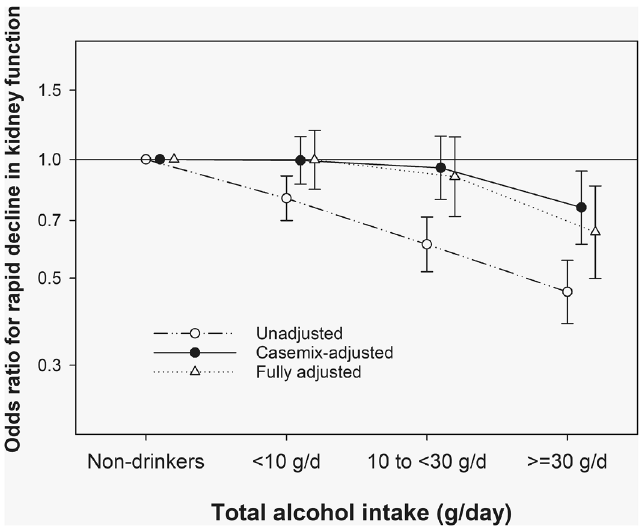
Figure 4. Association between total alcohol intake and rapid decline in kidney function (odds ratios) with three levels of adjustment in relation to baseline alcohol consumption among 5729